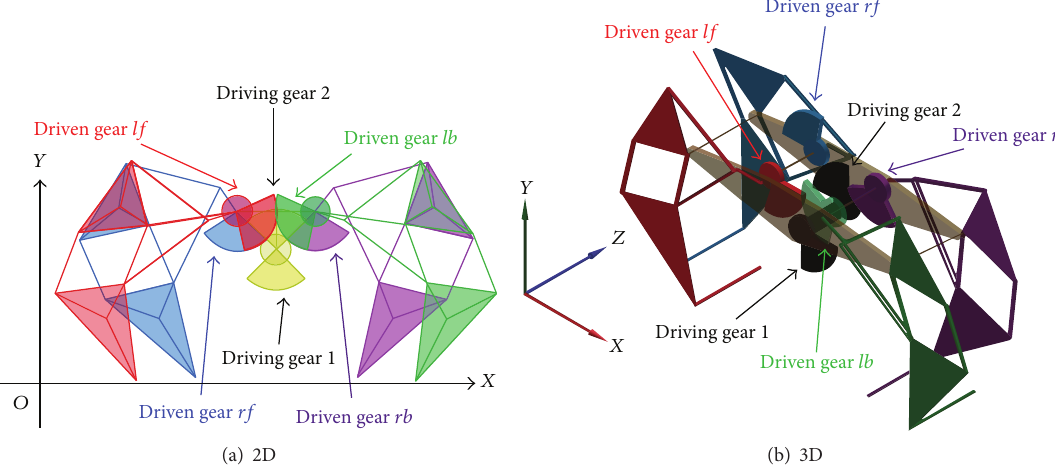
Figure 1: Schematic diagram of the quadruped robot composed of four Jansen linkage mechanisms and five gears which are driven by only one input attached to the bright yellow gear. The red, sky blue, green, and purple represent left-fore, right-fore, left-back, and right-back,